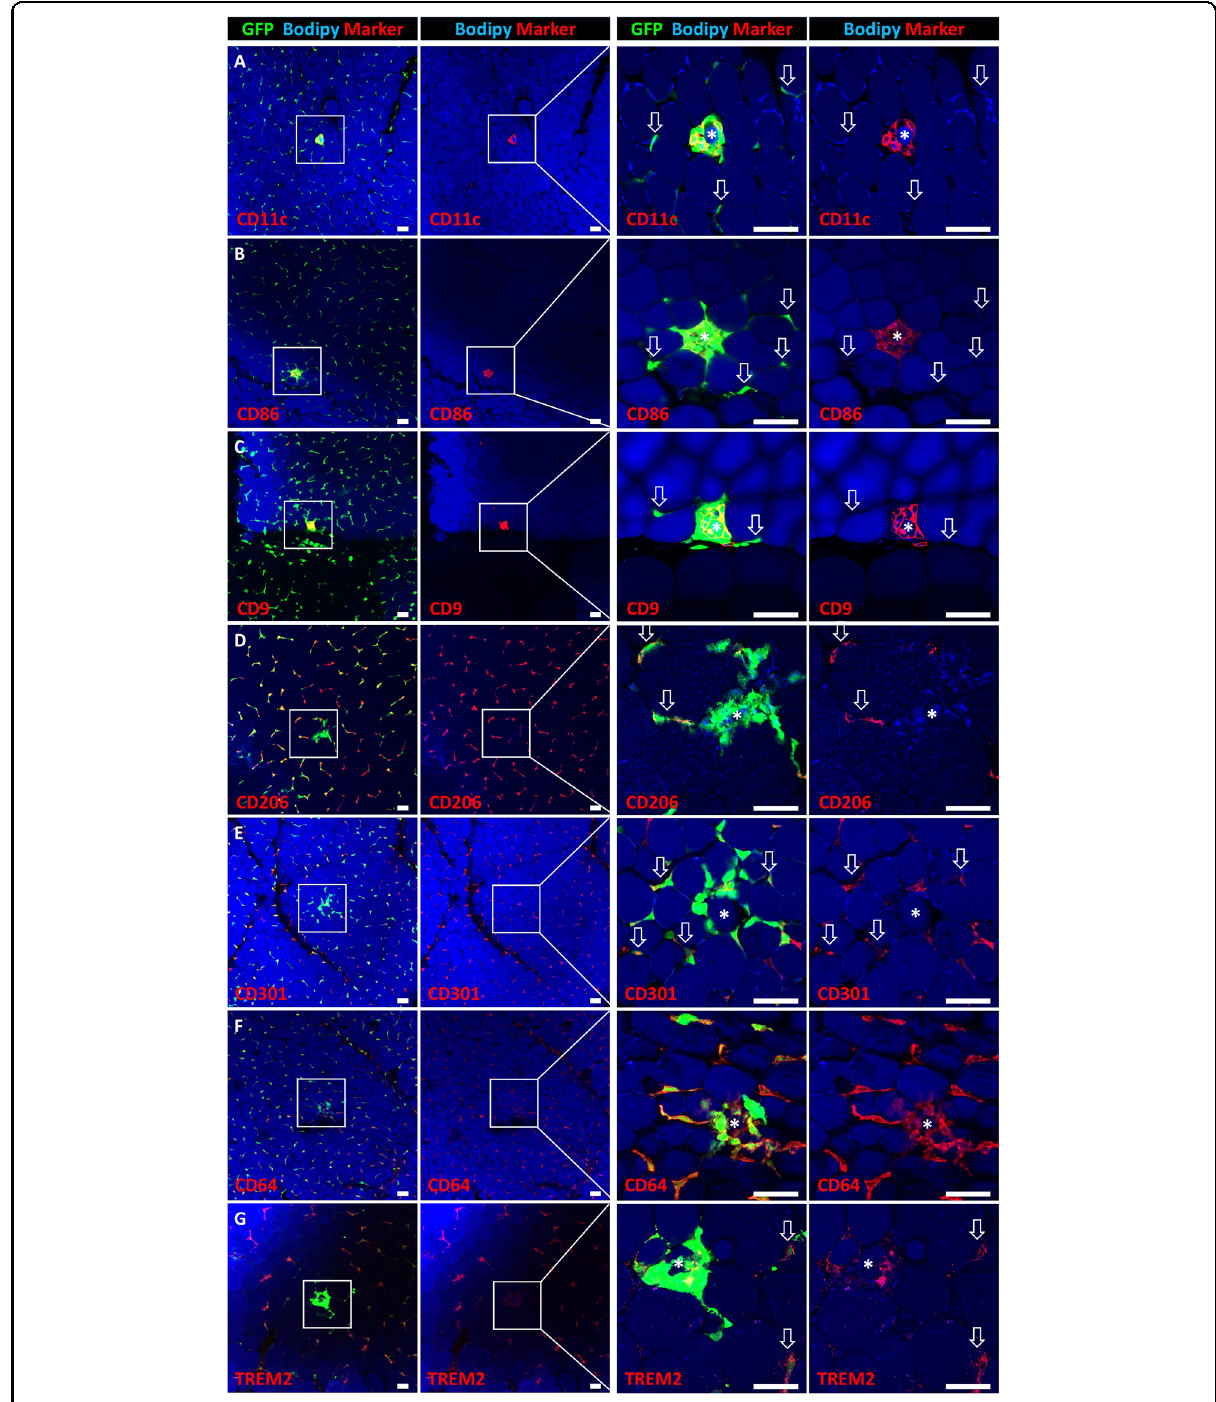
Fig. 5 In vivo formed CLS in lean mice show comparable in fl ammation marker expression to induced CLS. Whole mount antibody staining of CLS formed in vivo in lean mice under homeostatic conditions. A – C ATMs in in vivo formed CLS express pro-in fl ammatory markers CD11c, CD86, and CD9, while interstitial ATMs are negative (highlighted by arrows). D , E Interstitial ATMs express the anti-in fl ammatory markers CD206 and CD301 (highlighted by arrows), while ATMs in CLS are negative. F , G Expression of CD64 (all macrophages) or TREM2 (highlighted by arrows). Asterisks mark adipocytes inside CLS. Scale bars = 100